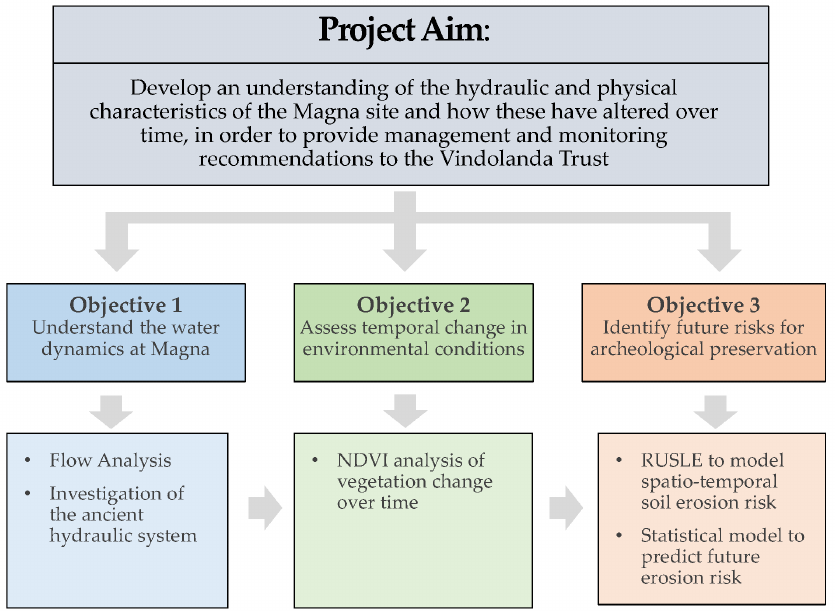
Figure 1. Flow diagram summarising the aims and objectives of this project and the adopted